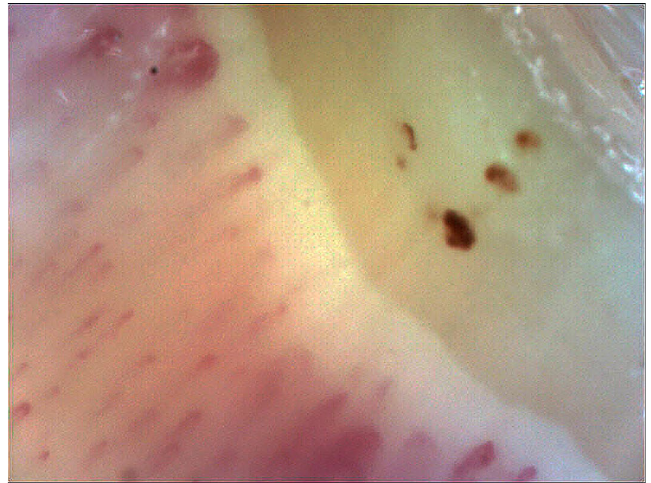
Figure 6. Nailfold capillaroscopy of a patient with low-tension disc hemorrhage showing three periungual